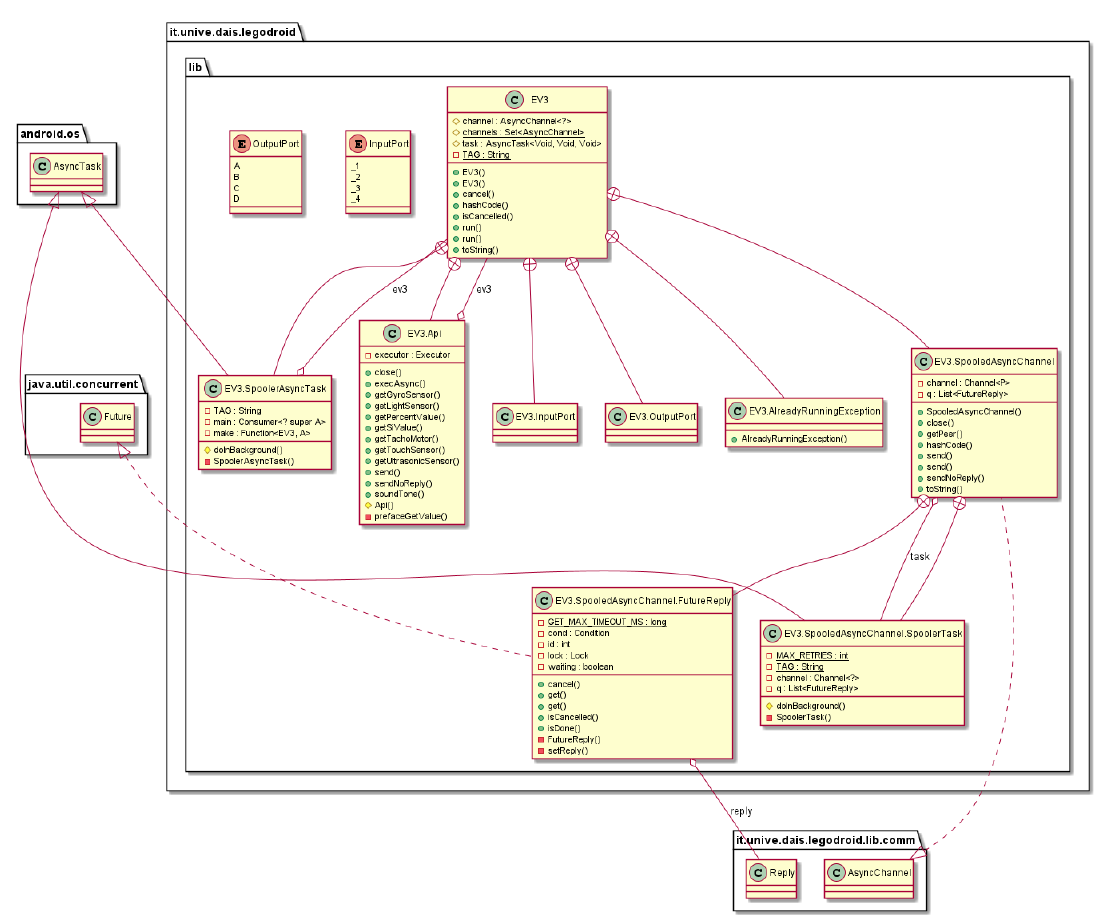
Figure 2. UML Class Diagram of package legodroid.lib